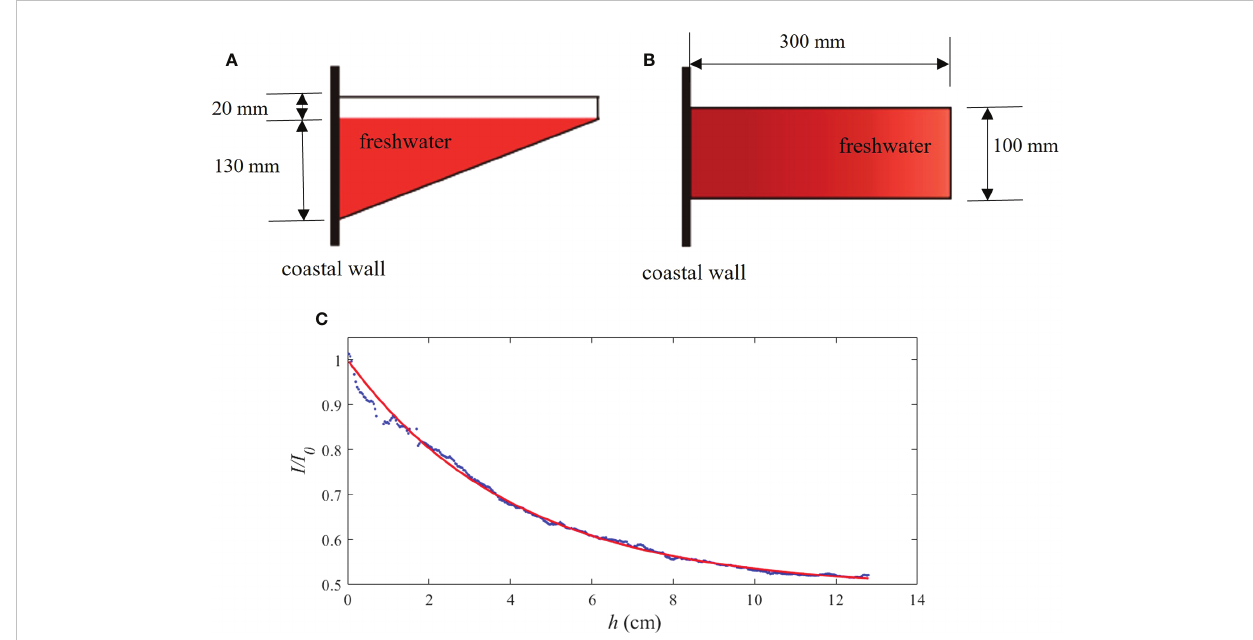
FIGURE 3 The calibration tank and normalized intensity-depth relationship. (A) Schematic of the calibration tank viewed from the side. (B) Schematic of the calibration tank viewed from above. (C) Relationship curve between normalized image intensity I/I 0 and depth h . Blue circles indicate data points; the solid red line is the fi tted curve.